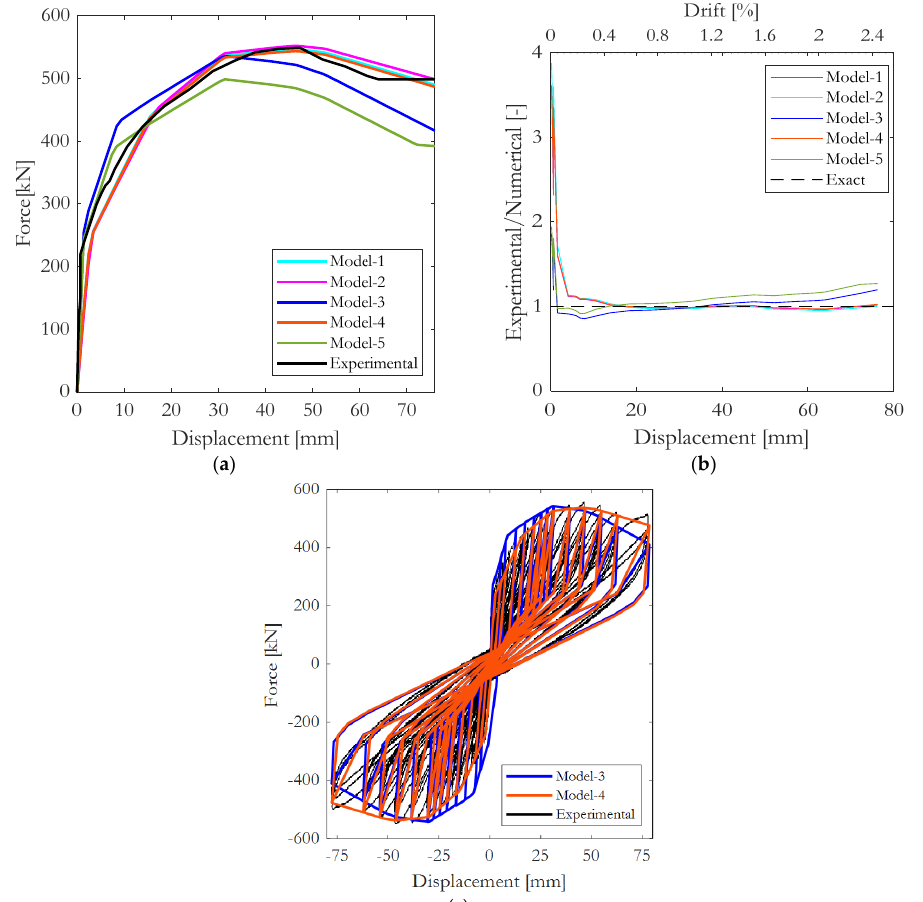
Figure 15. ( a ) Best numerical results versus experimental ones for infill type 4 [5]; ( b ) experimental-to-numerical capacity ratio for different models; ( c ) comparison of two of the best numerical models with in-plane static cyclic test results by Morandi et al. [5].